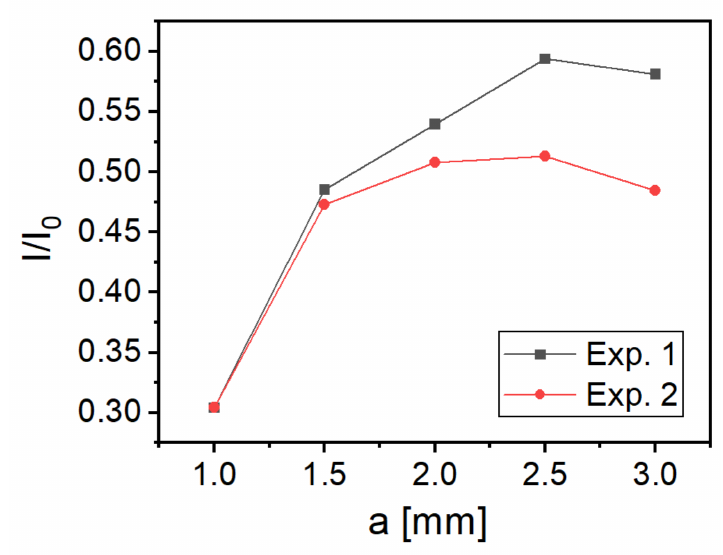
Figure 8. Normalized anode current as a function of the Einzel lens